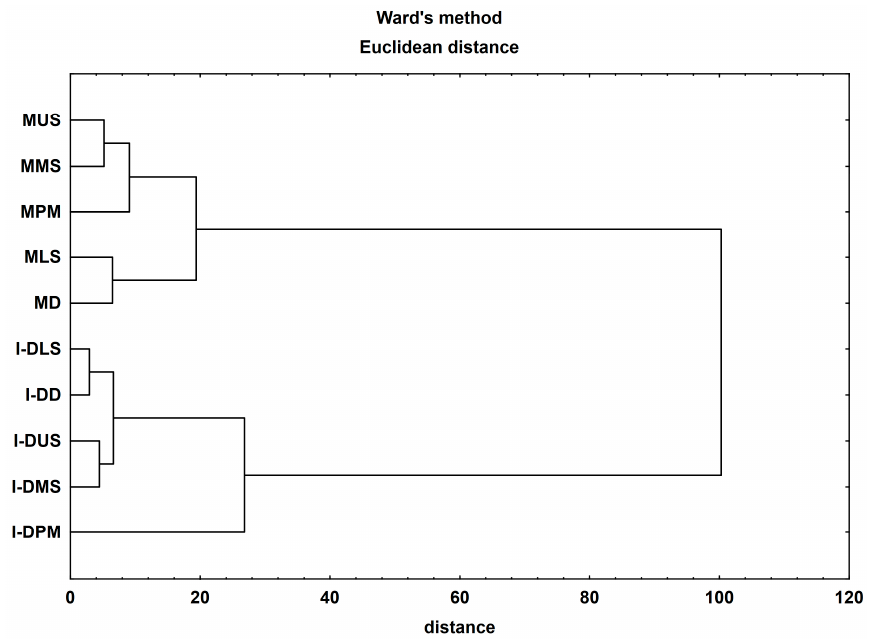
Figure 4. Clustering of soil PSD in humus horizons and parent material at different slope positions in moraine and ice-dammed lakes landscapes. Explanations were provided in the paragraph above.